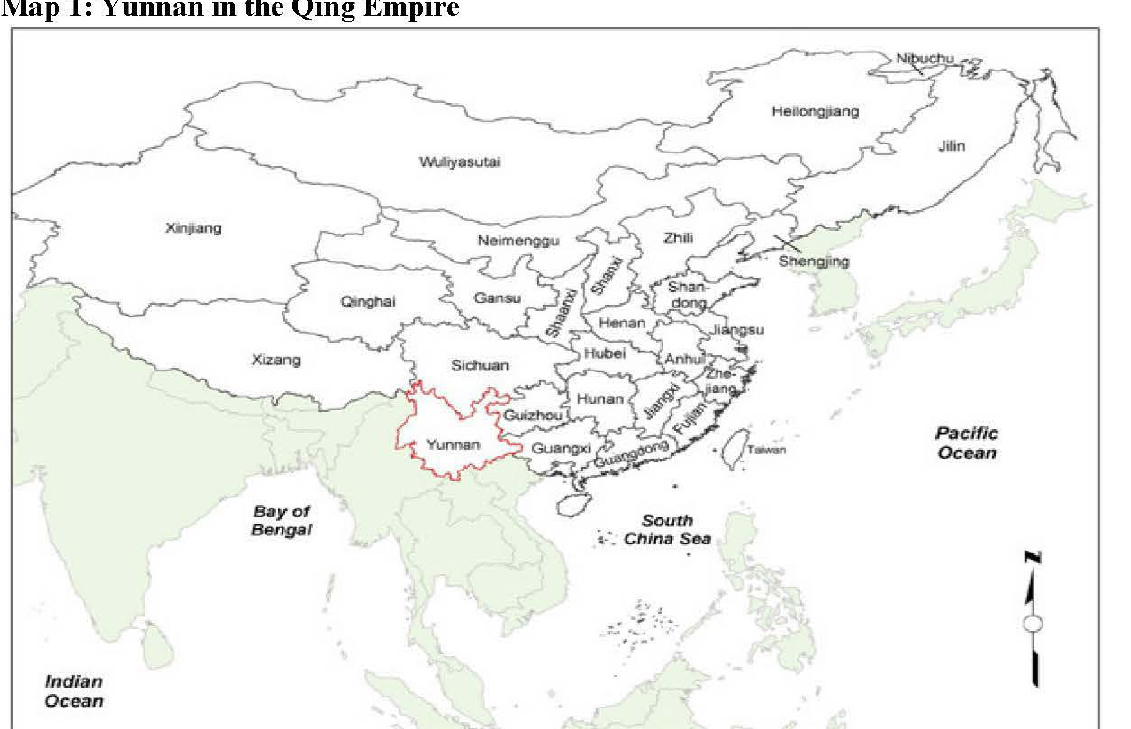
Map 1: Yunnan in the Qing